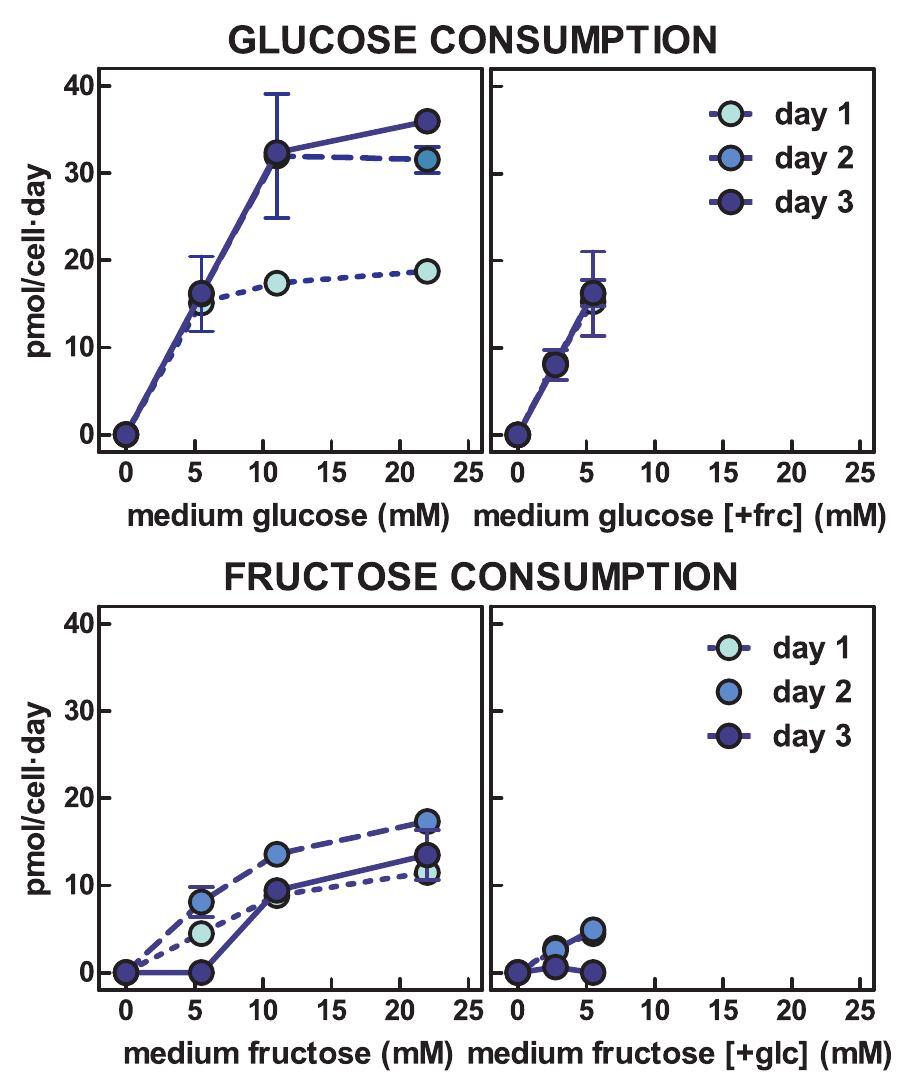
Fig 2. Glucose and fructose consumption by 3T3-L1 adipocytes exposed to a medium with varying concentrations of glucose, fructose or a combination of both. Each dot represents the mean ± sem of three different wells. Glucose or hexose consumption are expressed in pmol per cell and day. There were statistically significant (two-way anova) differences (P < 0.05) for 11 mM and 22 mM glucose absorption data on day 1 vs. days 2 and 3 (the latter only for 22 mM glucose). There were significant differences for fructose vs. glucose consumption for concentrations higher than 5.5 mM and for days 1 to 3. Fructose consumption in the presence of glucose was also statistically different from that of glucose in the presence of fructose for 2.75 mM to 5.5 mM initial medium levels. In the graphs where glucose + fructose were present in the medium, the X-axis legend shows the hexose measured, and the other present but not shown in the graph is represented between